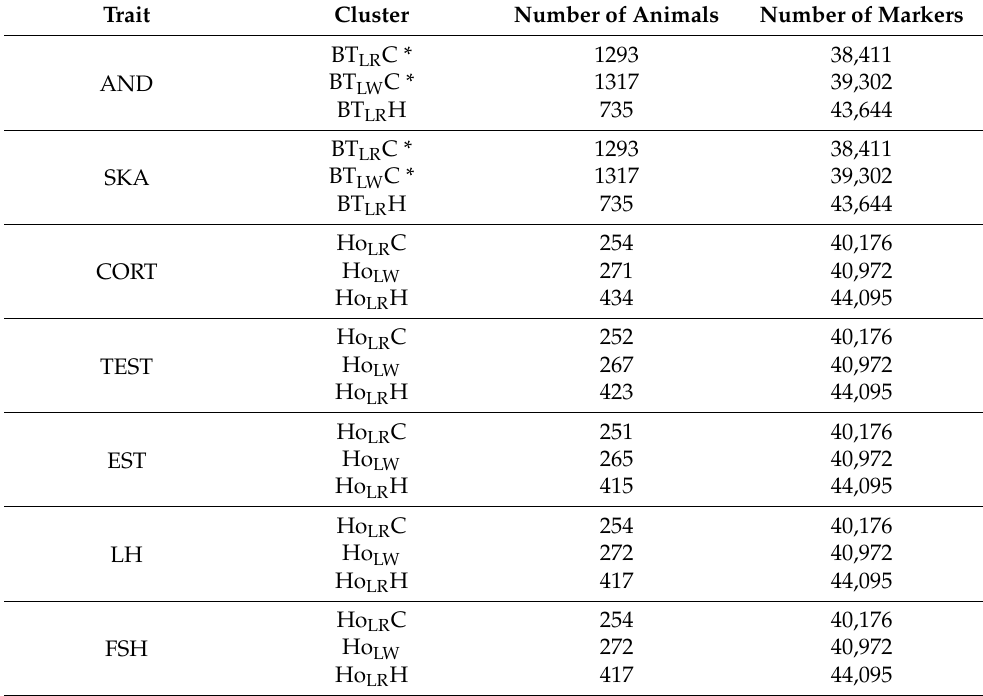
Table 1. Number of animals and markers per trait and cluster.